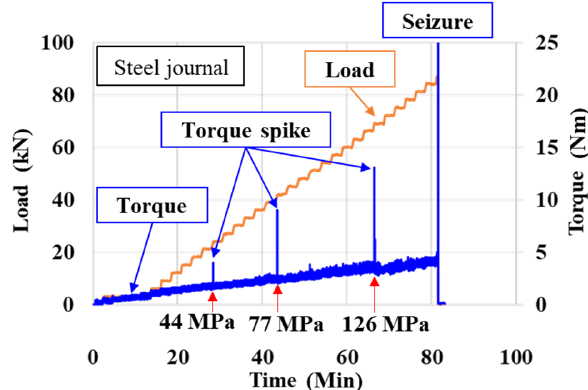
Figure 12. Torque characteristics of steel journal.